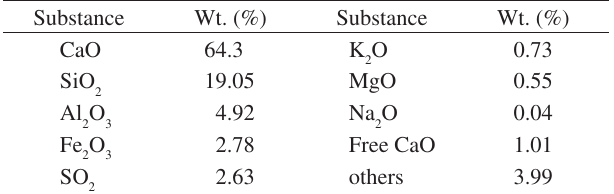
Table 1. Chemical analysis of the Portland ® cement used at the experiments. Substance